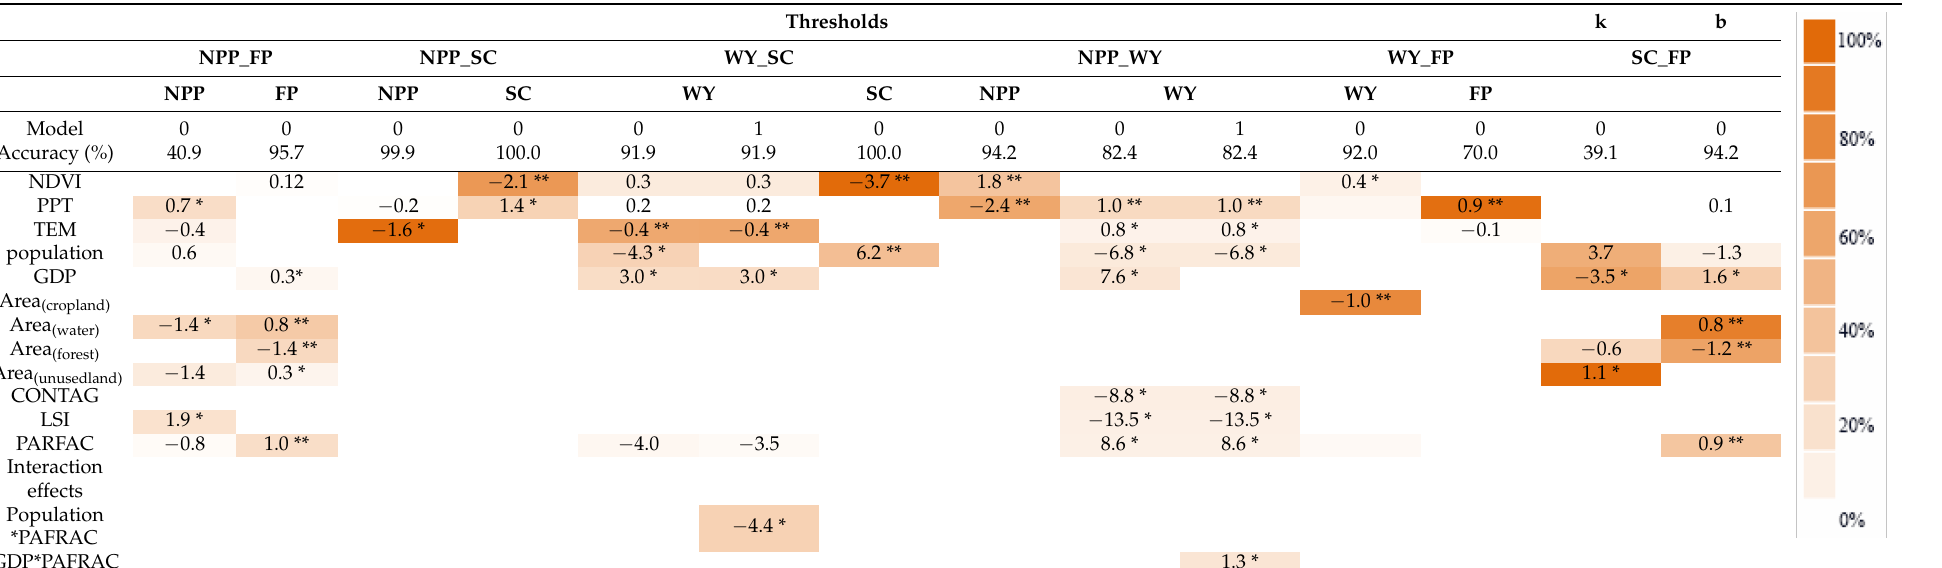
Table 5. Results of automatic linear modelling